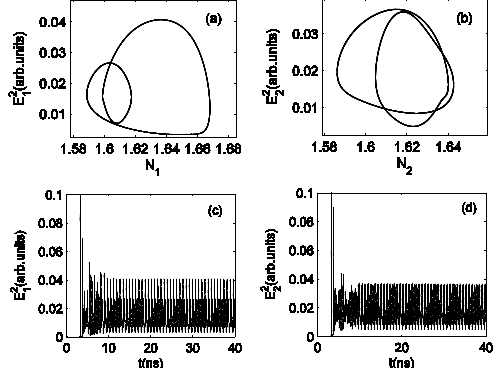
Fig. 2. Different double-cycle orbits of two lasers and output. (a) a double-cycle orbit of laser 1. (b) another double-cycle orbit of laser 2.(c) laser 1 output.(d) laser 2 output.